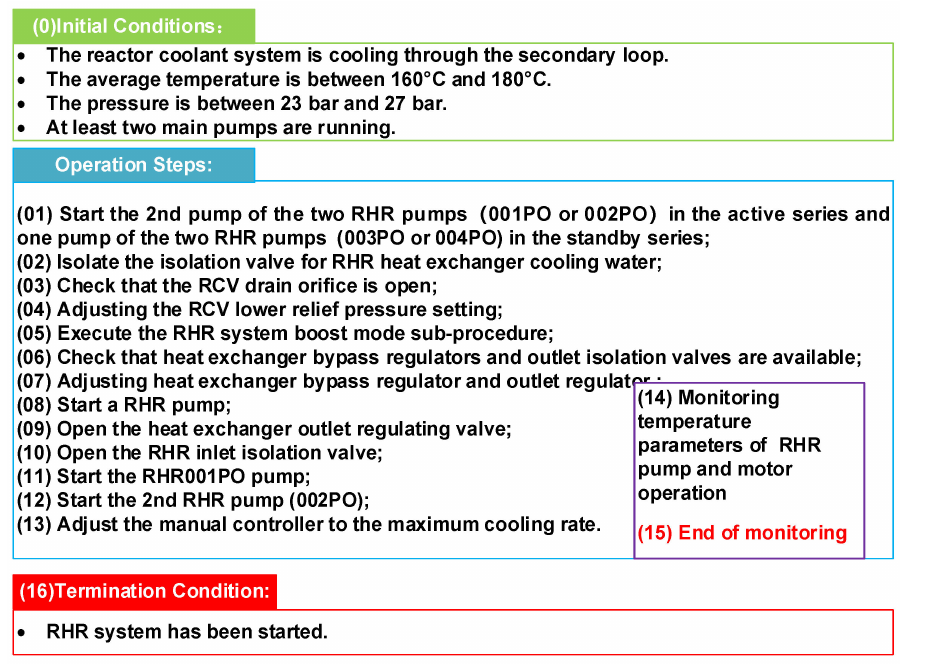
Figure 2. An operating procedure structure for RHR system